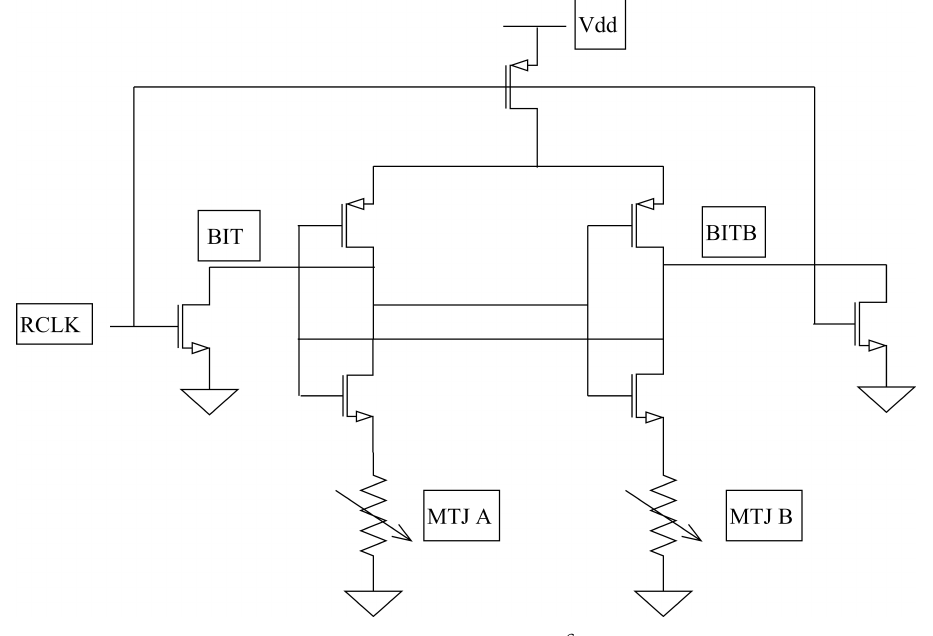
Figure 5. Design of P S .